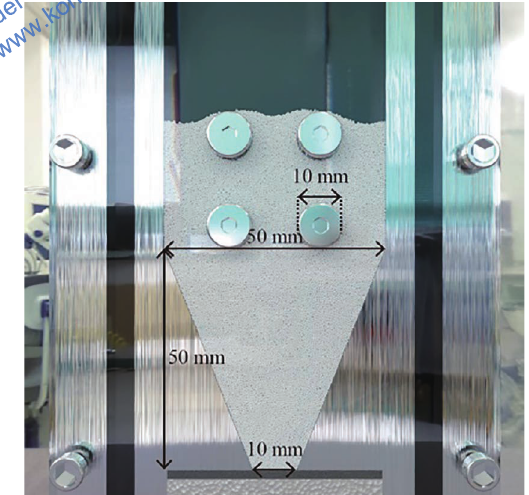
Fig. 5 Three-dimensional fluidized bed system (Mori, Wu and Sakai, 2019) Copyright: (2019) Elsevier B.V.